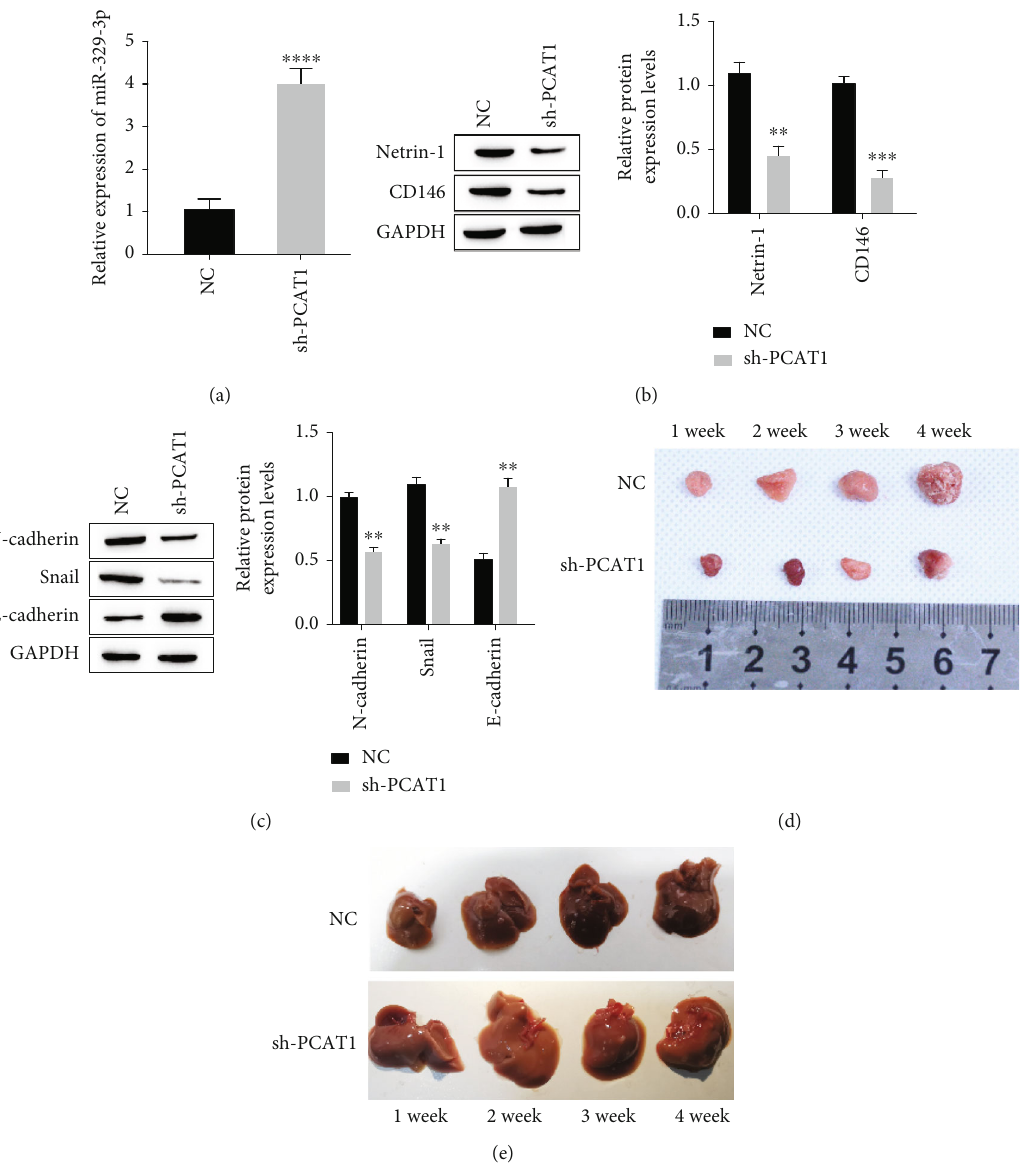
Figure 6: E ff ect of exosome PCAT1 on subcutaneous tumorigenesis and liver metastasis of colon cancer in vivo. (a) The expression of miR- 329-3p was detected by RT-qPCR. (b) The expression of Netrin-1 and CD146 was detected by western blot. (c) Western blotting was used to detect the expression of EMT-related proteins. (d) Observation of subcutaneous tumorigenesis size. (e) Observation of hepatic nodules. ∗∗ P < 0 : 01 , ∗∗∗ P < 0 : 001 , ∗∗∗∗ P < 0 : 0001 vs